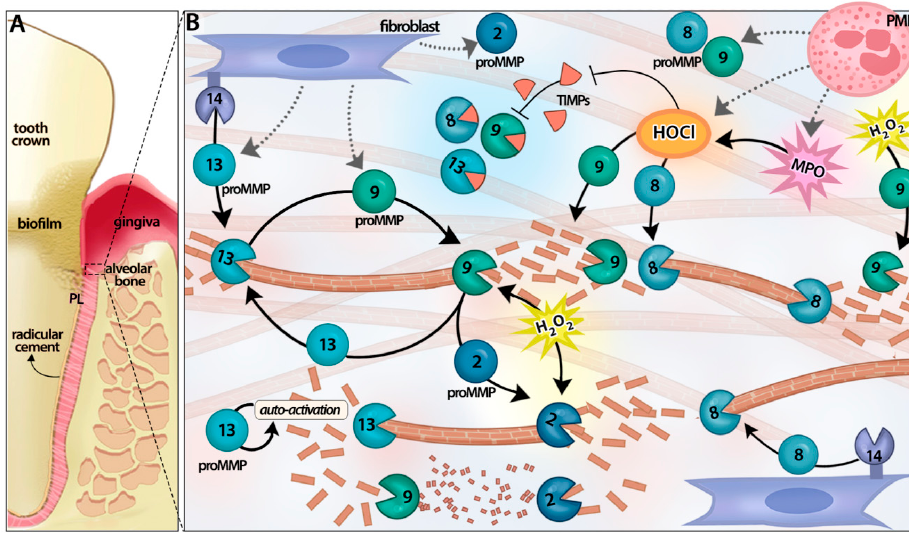
Figure 1. Matrix metalloproteinase (MMP) activation cascades in connective tissue catabolism during periodontitis. Full and partial circles with their respective number represent latent and activated specific MMPs. Brown T bars represent collagen fibers. ( A ) Tooth and its supporting structures: radicular cement, periodontal ligament (PL) and alveolar bone; ( B ) Membrane bounded MMP-14 activates proMMP-13 to degrade type I collagen, which constitutes the bulk component of radicular cement, periodontal ligament (PL) and alveolar bone extracellular matrix; MMP-13 activates proMMP-9, which in turn might activate proMMP-2 and proMMP-13. MMP-2 and MMP-9 further process gelatin resulting from collagenase activity. MMP-13 can undergo auto-activation by self-proteolysis. Reactive oxygen species, such as HOCl and H 2 O 2 , from phagocytes can also modify the proteases/anti-proteases balance, activating latent MMPs and inactivating the tissue inhibitor of MMPs (TIMP)-1. MPO,